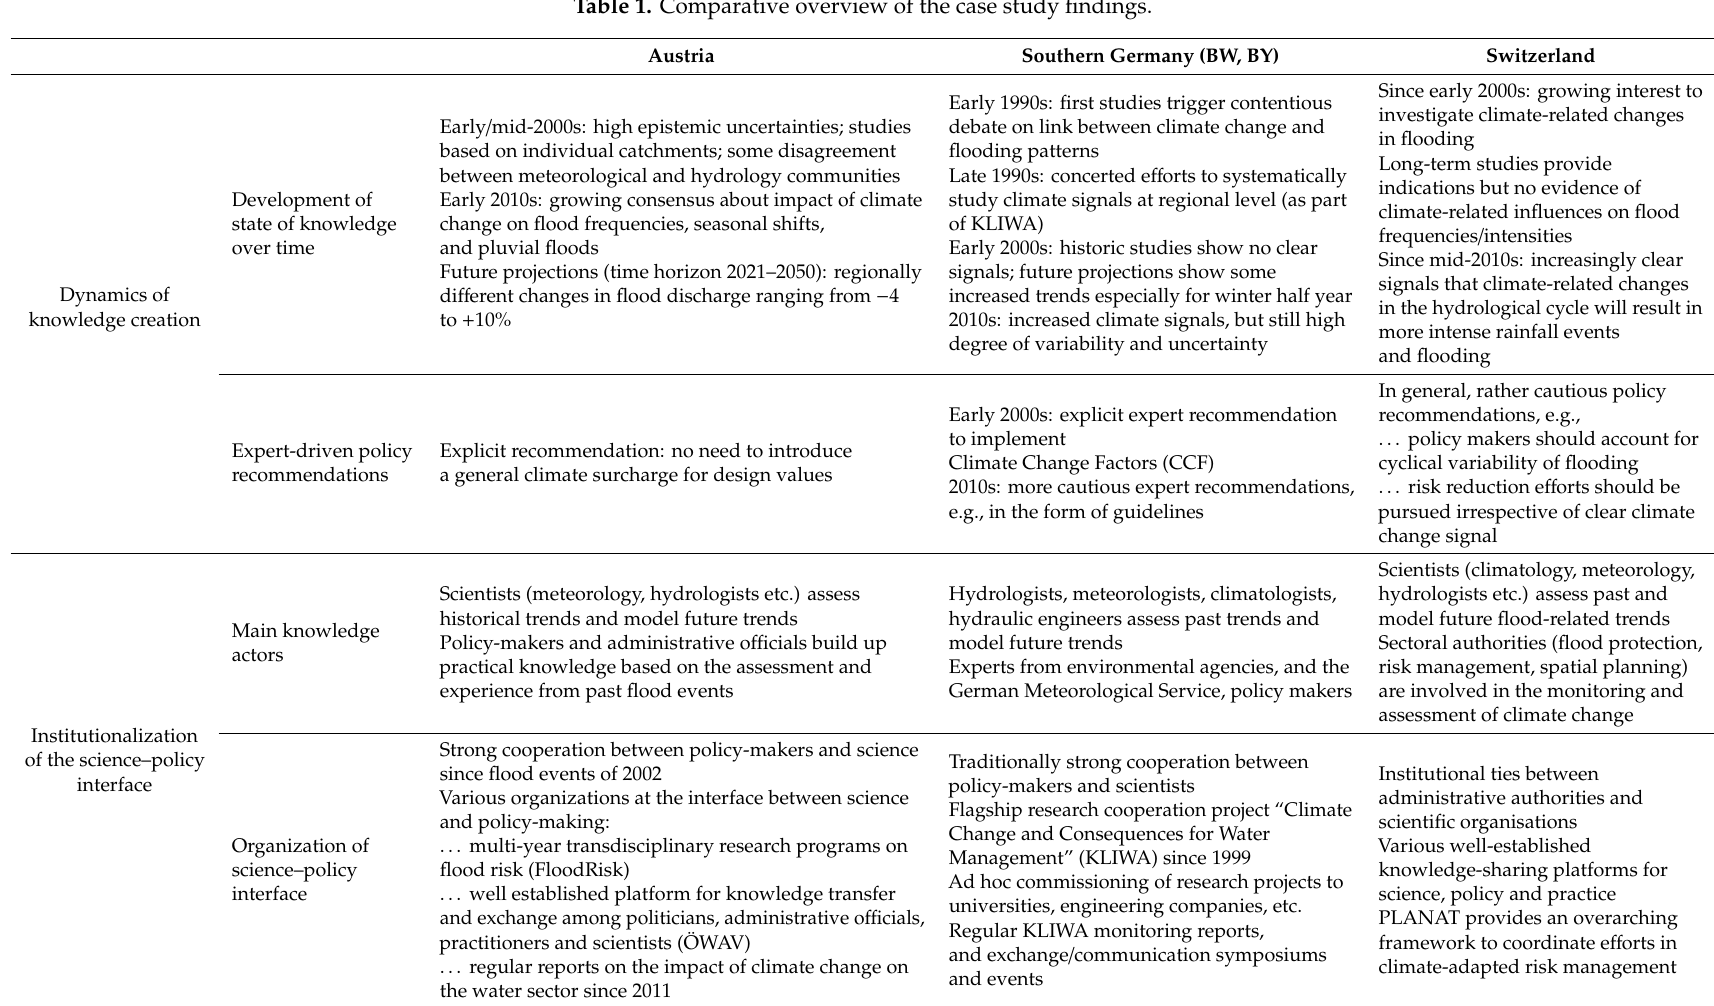
Table 1. Comparative overview of the case study